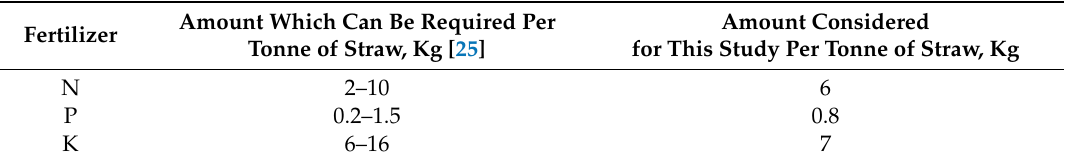
Table 6. Nutrient replacement due to straw